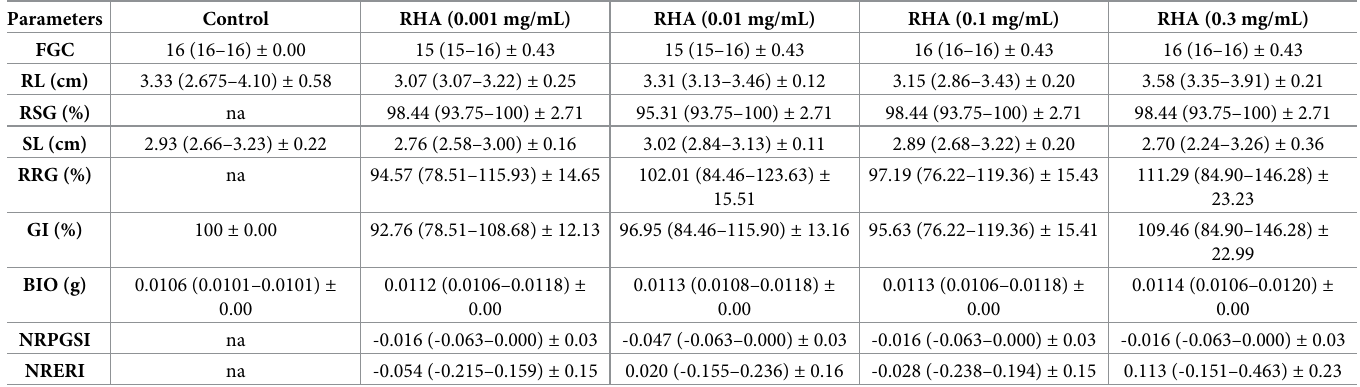
Table 3. Phytotoxic effects of RHA against Lactuca sativa .